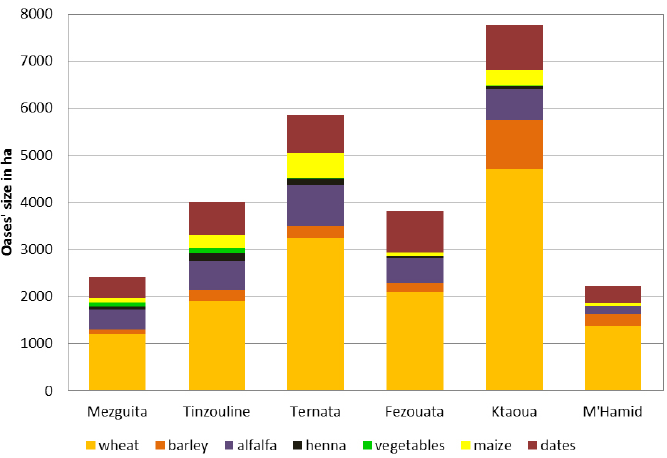
Figure 3. Area used for agriculture in ha per oases and crop type in the current account year 1978 [26].